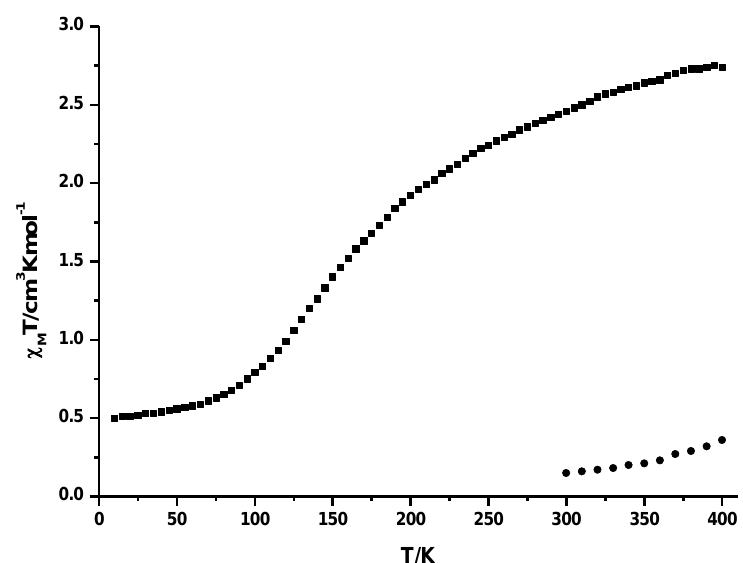
Figure 1. χ M T vs. T data for the compounds C1 (dots) and C2 (squares). The Data is given per molecule.